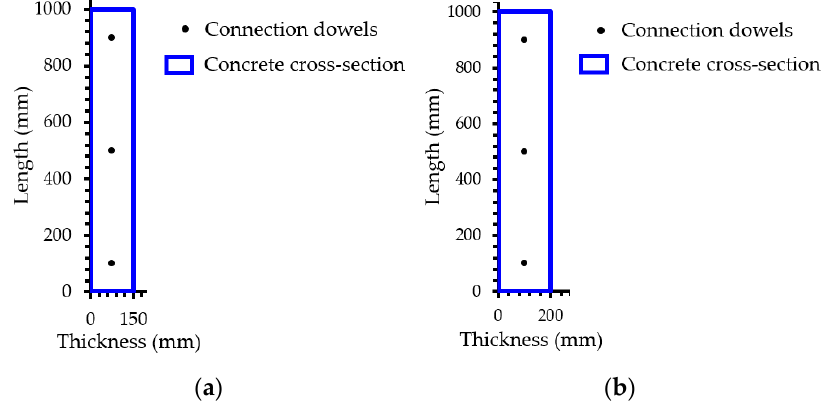
Figure 7. Definition of the critical cross-sections of SW1 and SW4 in WHAM [41]. ( a ) Cross-section of SW1 at base. ( b ) Cross-section of SW4 at base.